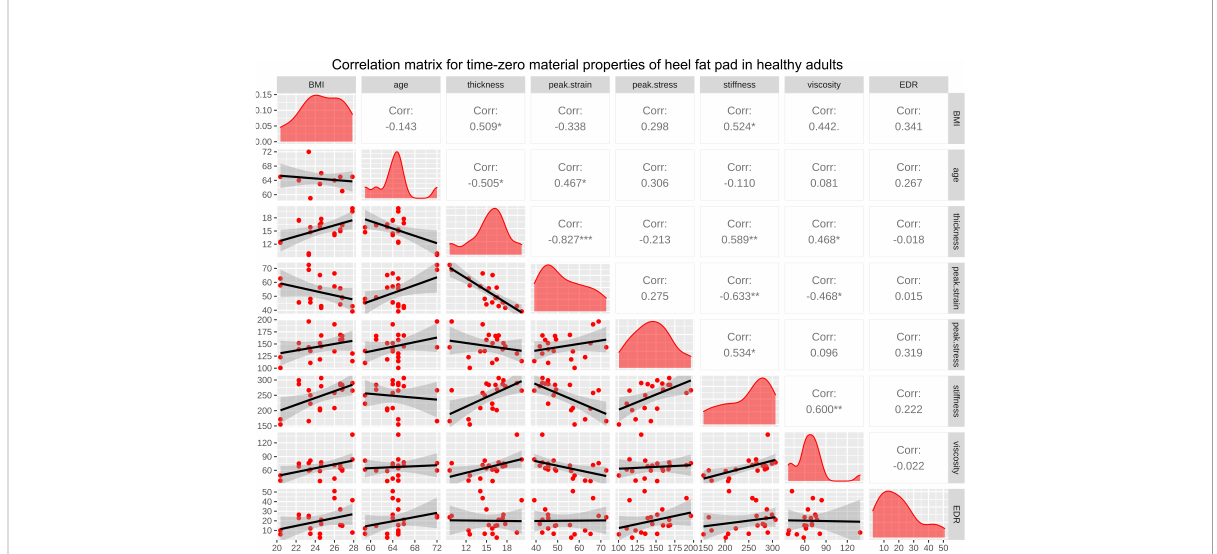
FIGURE 4 The correlation matrix for time-zero BMI, age, primary thickness, peak strain, peak stress, stiffness, viscous modulus, and EDR of heel in healthy adults. The values displayed in the right-upper triangle represent the Pearson ’ s correlation coef fi cients (R values). The lower-left triangle displays the scatter plots and regression lines. The plots on the diagonal line present the distribution density of the variables in the matrix. BMI: body mass index; EDR= energy dissipation rate. P values:.p<0.100, *p<0.050, **p<0.010, ***p<0.001.